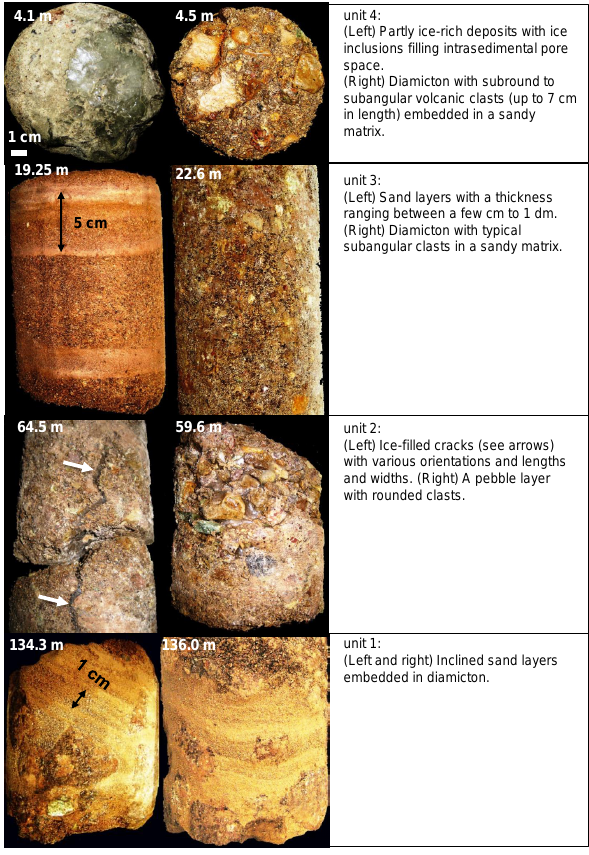
Fig. 5. Photographic examples of sediment structures and ice features in units 1 to 4. The core diameter is 11 cm.